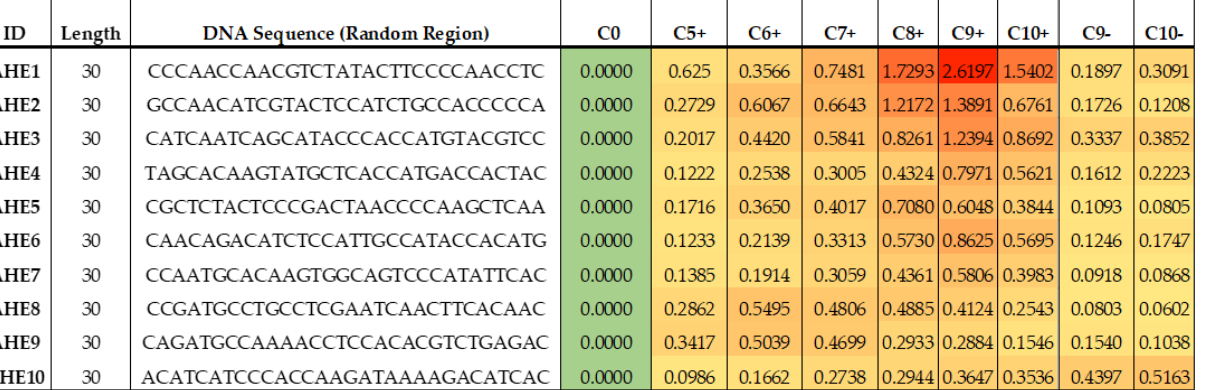
11 of 19 Figure 3. Deep sequencing analysis of SELEX. The starting library and the libraries after cycle 5 were analyzed. Sequences whose frequency is higher than 0.01% at least in one cycle were recovered and their percentage in the library as well as their number were measured for several cycles ( A , B ), re- spectively). Those sequences have been clustered in families based on an edit distance of 6. The evolution of the number of families is presented in ( C ). The frequency of the 10 most enriched fam-